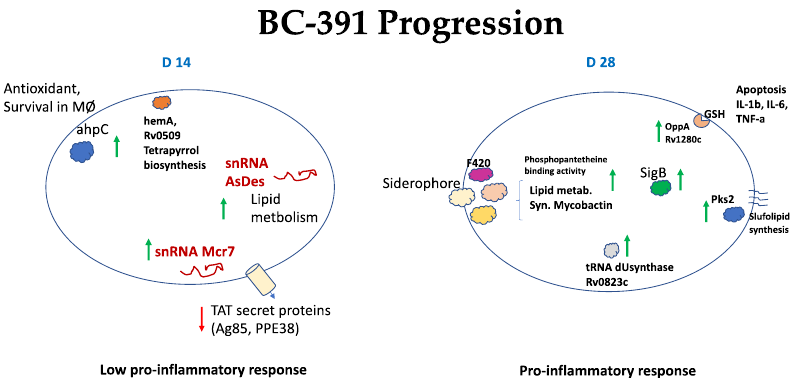
Figure 7. Schematical model describing key genes involved in progression of the infection in the murine model of the strain BC-391 at day 14 and 28 PI. Up and green arrows indicate over-expressed genes and down and red arrows indicate under-expressed genes.